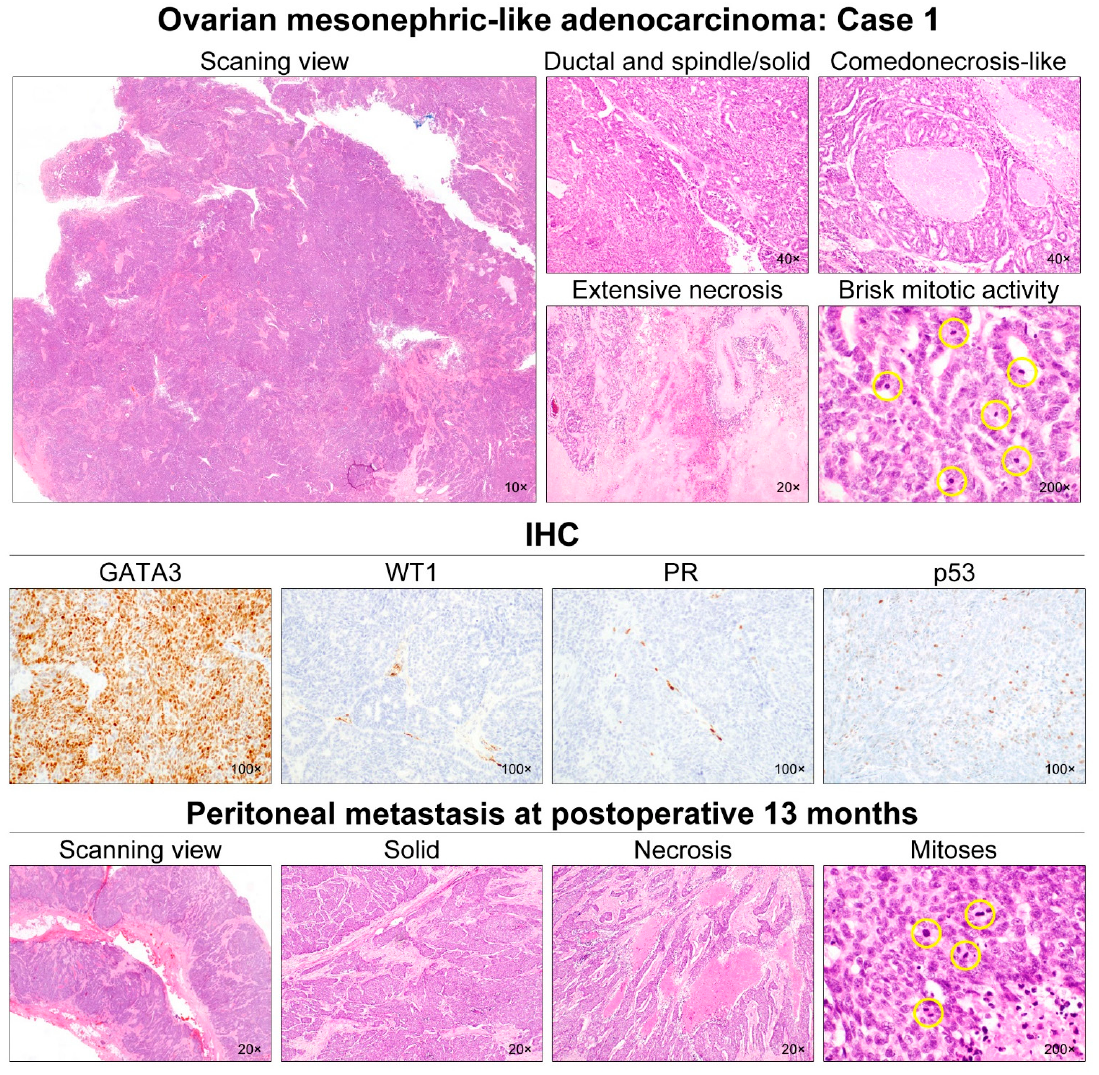
Figure 2. Histological features of ovarian MLA: Case 1. The ovarian mass was a 7.5-cm cystic lesion with some internal mural nodules. At scanning magnification, the mural nodules appeared solid and deeply basophilic due to hypercellularity. They consisted of adenocarcinoma, showing ductal and solid growth patterns. Most of the tumor cells formed a complex cribriform and solid architec- ture with slit-like glandular spaces. We noted some foci of intraluminal necrosis and karyorrhexis within the cribriform architecture, resembling comedonecrosis observed in ductal carcinoma in situ of the breast. Even though most of the tumor cells exhibited mild-to-moderate nuclear pleo- morphism, some areas showed severe nuclear pleomorphism, extensive coagulative tumor cell ne- crosis, and brisk mitotic activity (27/10 high-power fields). Immunostaining revealed that the tumor cells were completely negative for WT1, ER, PR, and p16; p53 expression pattern was wild-type. Since the tumor was confined within the right ovary (FIGO stage IA), the patient received no further treatment. However, at 13 months post-operatively, she developed multiple metastases in the ab- dominopelvic peritoneum, liver, and lungs. The metastatic lesions displayed solid growth pattern with scattered foci of coagulative tumor necrosis. Similar to the primary tumor, the metastatic tumor cells showed severe nuclear pleomorphism. Mitotic count (25/10 high-power fields) was similar to that of the primary tumor. The yellow circles are intended to highlight the mitotic figures, which just appear very small dark spots.